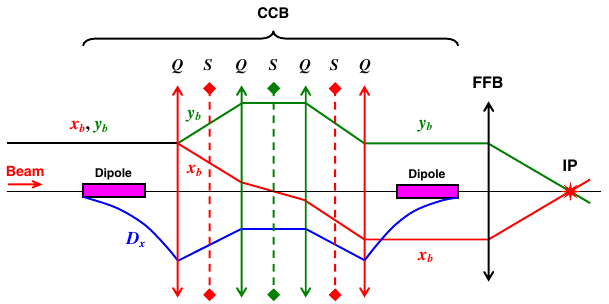
FIG. 3. A conceptual drawing of an IR with a CCB that has an odd-symmetry horizontal betatron trajectory x b , an even- symmetry vertical betatron trajectory y b , and an even-symmetry horizontal dispersion D x . It shows a possible arrangement of dipoles, quadrupoles Q , and sextupoles S that satisfies the magnetic field symmetry requirements and produces the desired symmetries of x b , y b , and D x